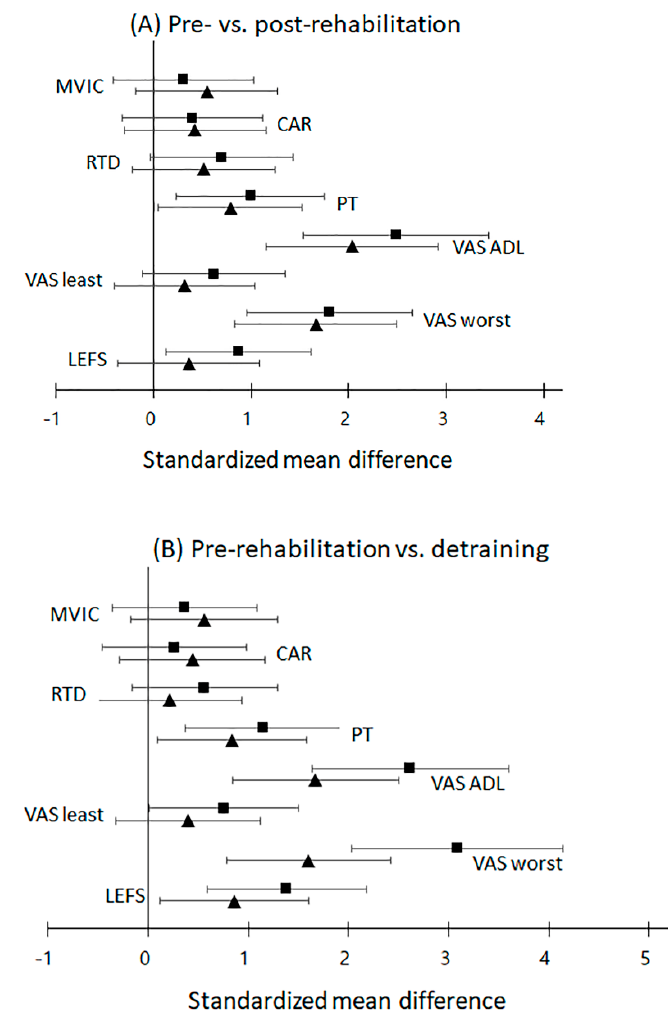
Figure 3. Forest plots of the outcome measures. Squares (modality + exercise condition) and triangles (exercise alone) with 95% confidence intervals indicate effect size estimates of mean difference between pre- and post-rehabilitation ( A ) and between pre-rehabilitation and detraining ( B ). All effect sizes and confidence intervals are positive (on the right side of the vertical zero line), indicating that either treatment condition was beneficial; confidence intervals of each outcome measure (e.g., MVIC) overlap, indicating the difference between treatment conditions were not statistically different. ADL: activities of daily livings; CAR: central activation ratio; LEFS: lower-extremity functional scales; MVIC: maximal voluntary isometric contraction; PT: peak torque; VAS: visual analog scale.